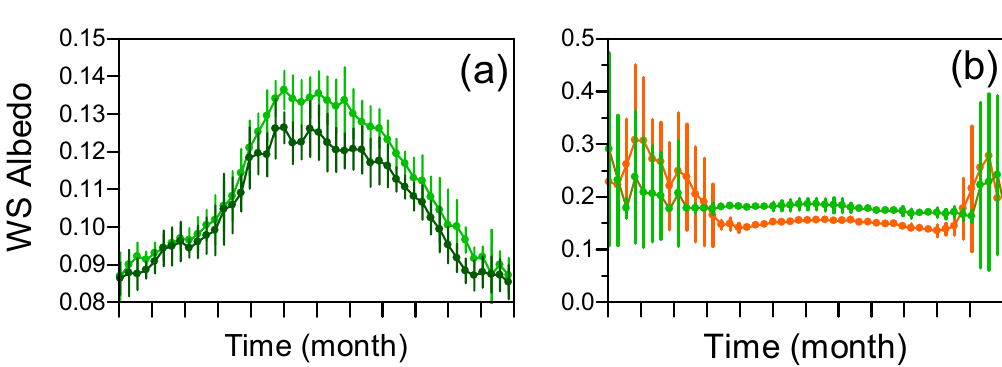
Figure 4. Twelve years (2000–2011) of 8-day mean ± SD MODIS white-sky albedo over ( a ) needle leafed forests (dark green) and broadleaf forests (light green) and ( b ) low shrublands (brown) and natural grasslands (light